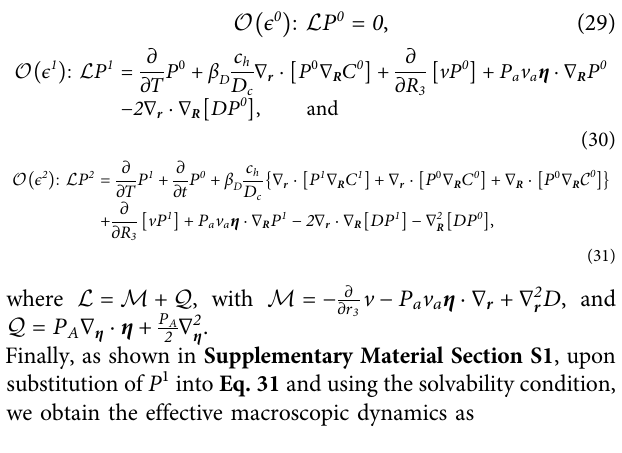
FIGURE 2 | Consequences of bio-enhanced premelting in the absence of nutrients ( β D = 0). The evolution of the probability density along the ~ z -axis, computed from Eq. 32 with N i = 50 μ M m − 2 and four biological enhancement factors n ∈ {1,2, 3,4},where N = nN i .Theprobabilitydensity isshown at ~ x (cid:2) ~ y (cid:2) 0 and at time ~ t (cid:2) 300 years. The analytic solution (solid lines), (see Supplementary Material Section S2 ), is compared with the numerical solution (dots) of Eq. 32 . The particle radius is R = 9.0, ×, 10 − 6